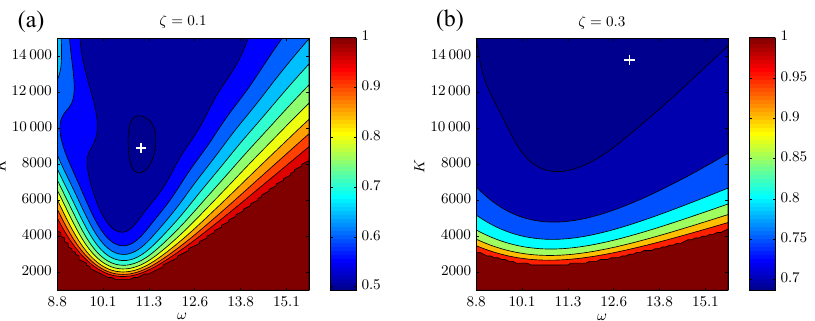
Figure 8. Close-up of the optimal parameter combinations for the drivetrain excitation problem with ζ = 0 . 1 (left) and ζ = 0 . 3 (right). The results are thresholded and normalized for clarity. The results show large areas where the cost function is almost optimal. The minimum values of the cost function for each case are indicated by the white +